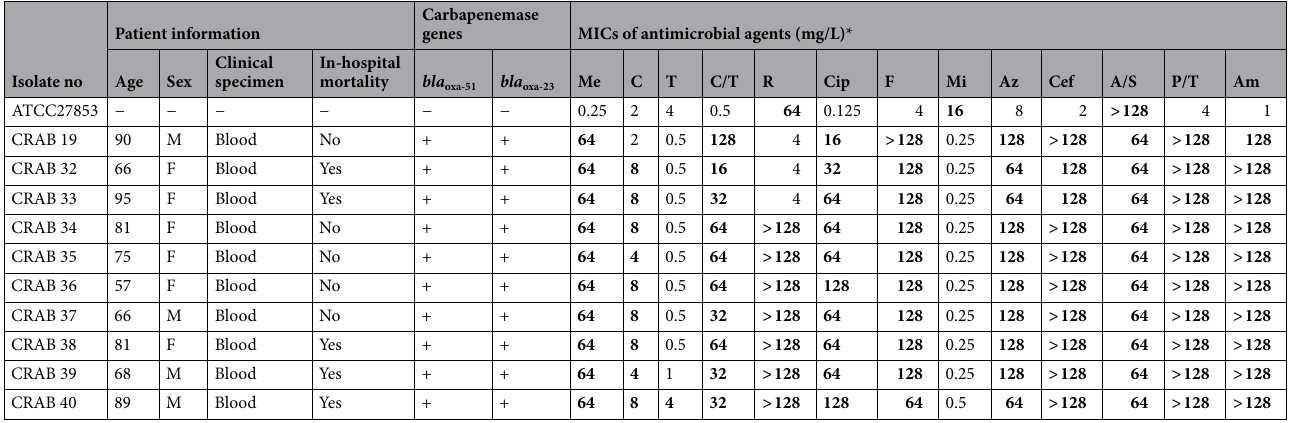
Table 2. Clinical and microbiological characteristics of Acinetobacter baumannii isolates. Am amikacin, A/S ampicillin/sulbactam, Az aztreonam, Cef ceftazidime, CRAB carbapenem-resistant Acinetobacter baumannii , Cip ciprofloxacin, C colistin, C/T ceftolozane/tazobactam, F female, F fosfomycin, M male, Me meropenem, Mi minocycline, MIC minimum inhibitory concentration, P/T piperacillin-tazobactam, R rifampin, T tigecycline. *Bold values, non-susceptible; white cell,